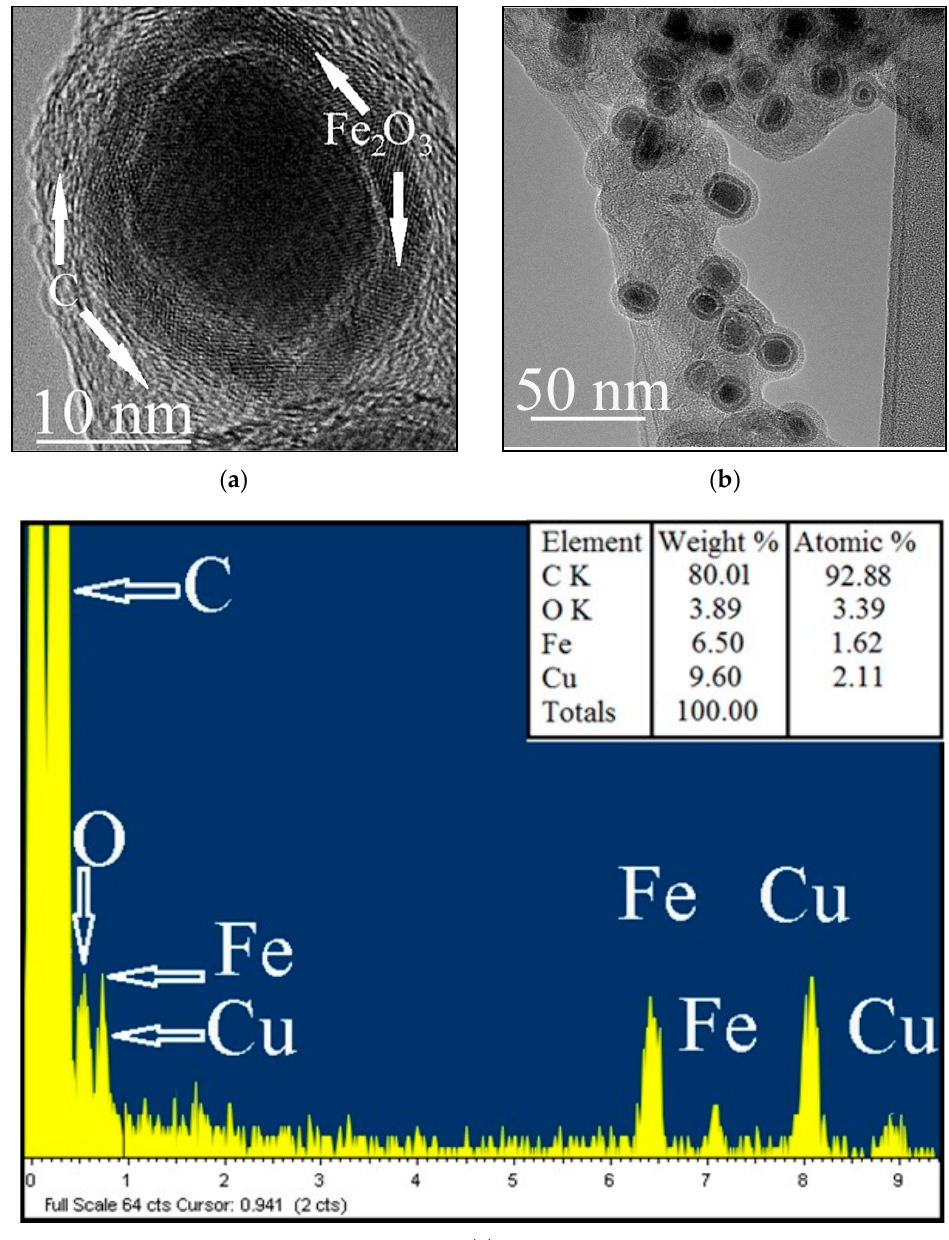
Figure 4. Fe ‐ containing carbon nanocapsules: ( a ) general TEM view manifesting mean particle size 15–30 nm; ( b ) detailed structure of a nanocapsule by TEM (arrows indicate two encapsulating shells: inner Fe 2 O 3 shell and outer carbon shell); ( c ) EDS spectra from view ( a ).